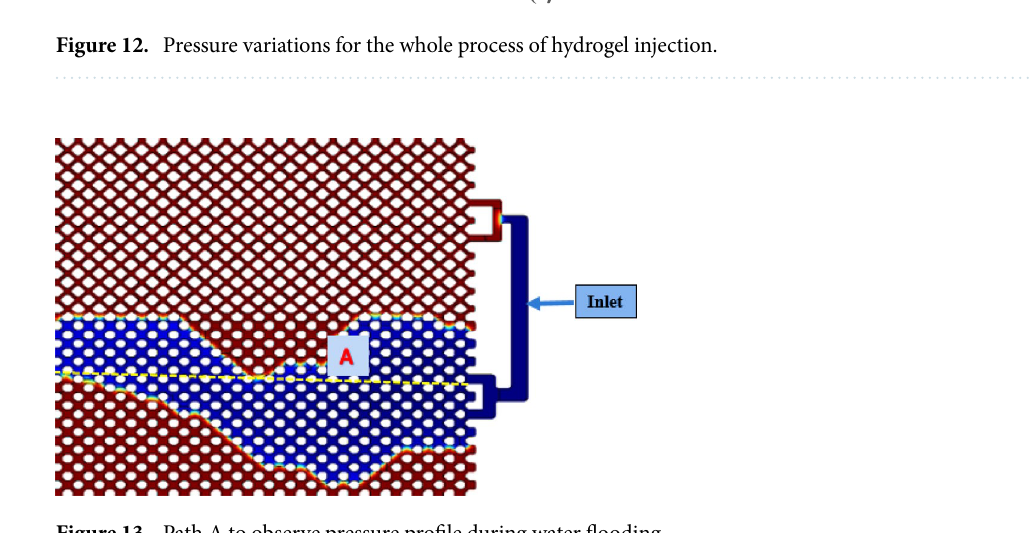
Figure 13. Path A to observe pressure profile during water